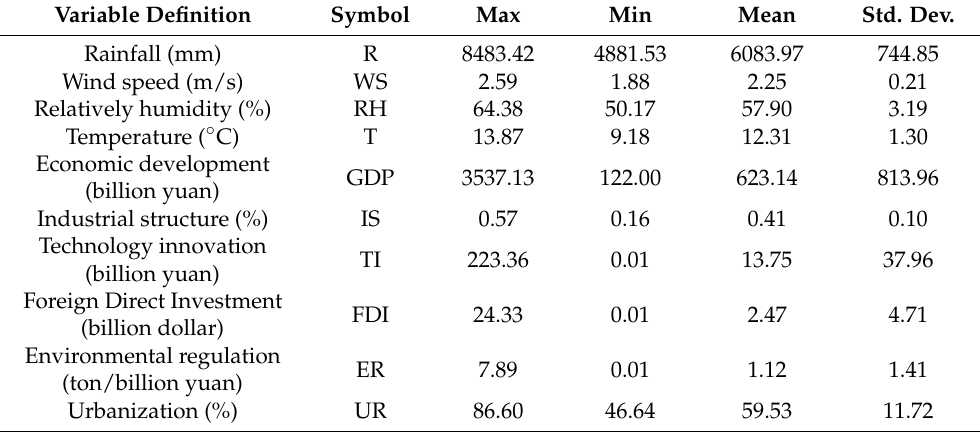
Table 1. Statistical summary of the variables.